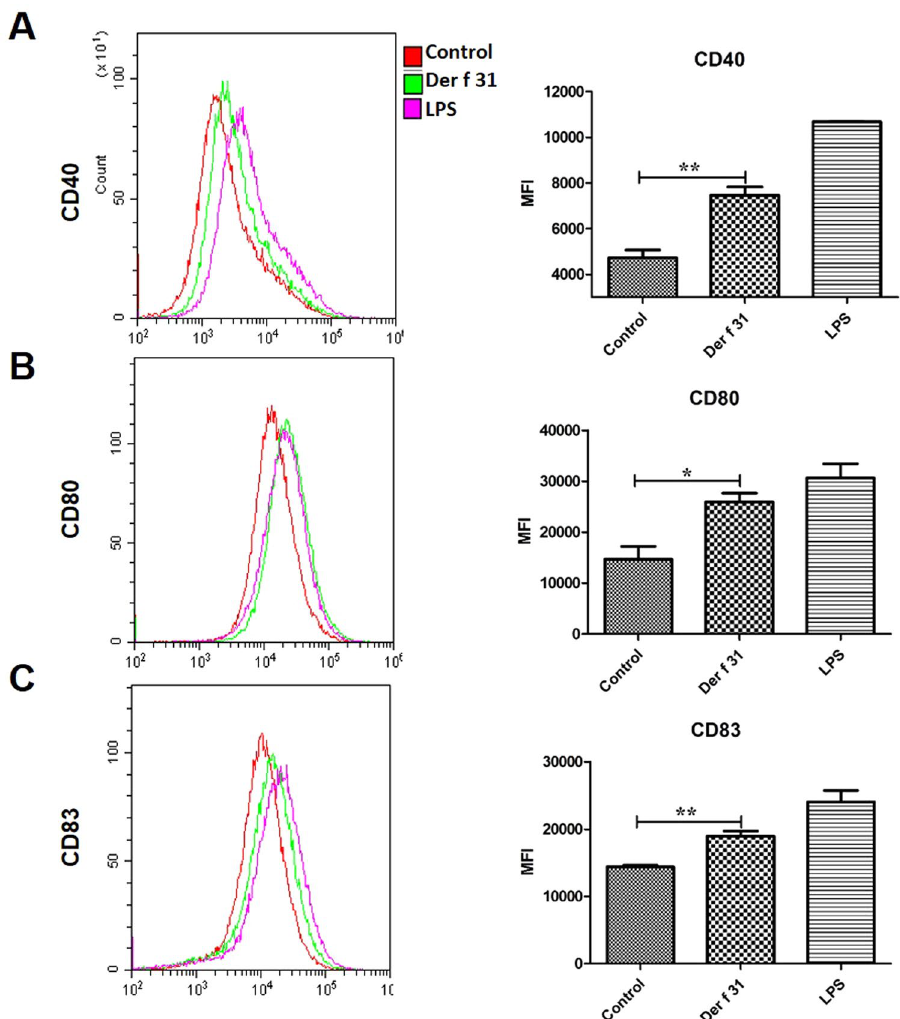
Figure 1. Co-stimulatory molecules are up-regulated by Der f 31. DC2.4 cells were seeded into 6-well plates for overnight culture and then stimulated with Der f 31 (20 μ g/ml) or LPS (1 μ g/ml) for 24 hours. The expression levels of CD40 ( A ), CD80 ( B ) and CD83 ( C ) were tested by flow cytometry. These data (means ± SEMs) were generated from three independent experiments and processed with GraphPad software. The significant differences between two groups were tested by two-tailed T-test. * p < 0.05. ** p <